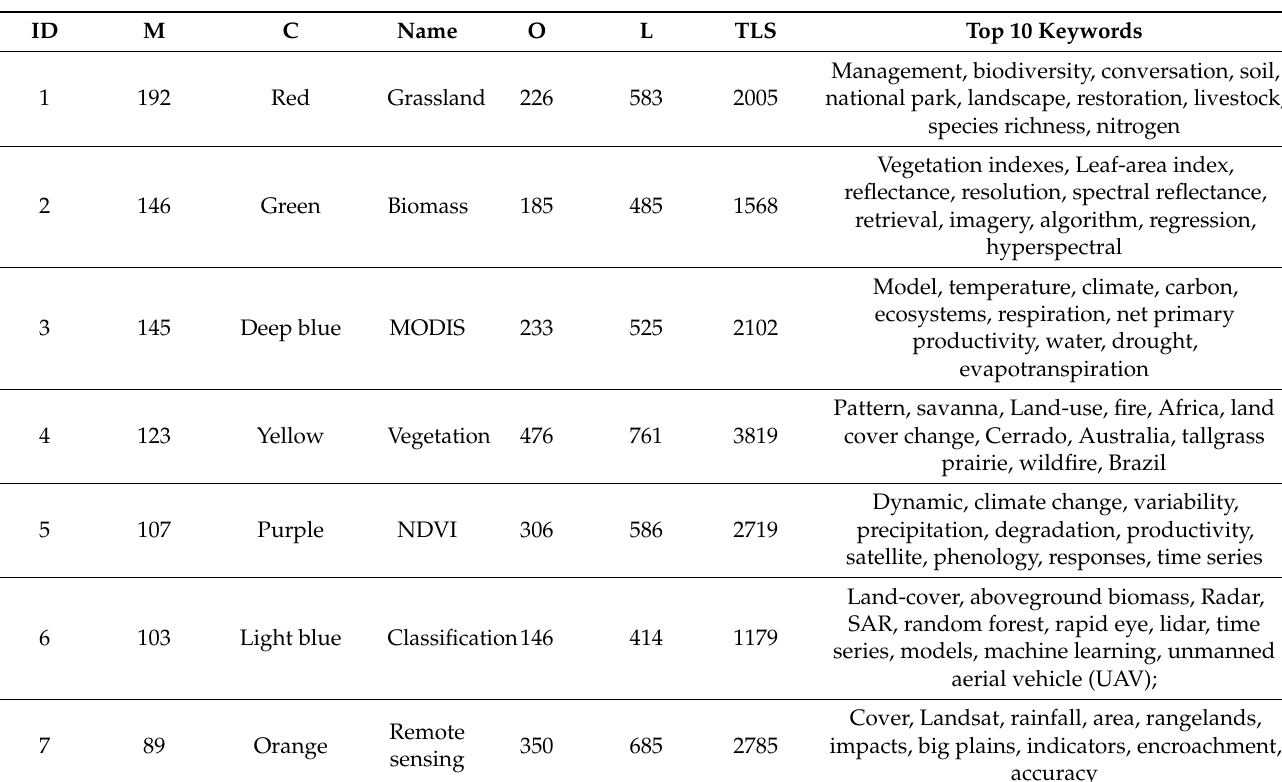
Table 6. Identified clusters of keywords on GRS research from 1980 to